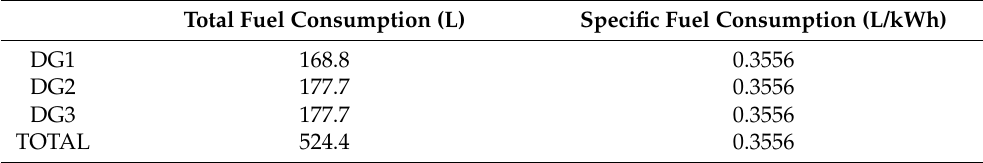
Table 4. DG units total and specific fuel consumption for off-grid operation (base